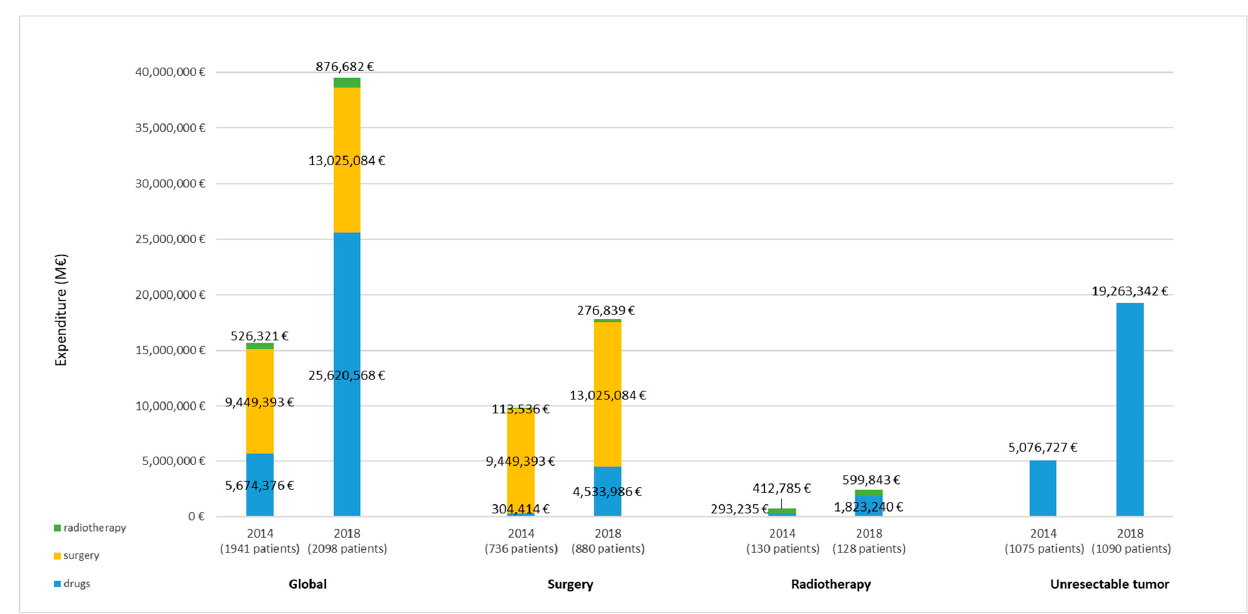
Figure 3. Pharmaceutical expenditure in 2014 and 2018 according to treatment pattern. Notes: The aggregated costs of the procedures were determined according to the treatment pattern followed in each patient. The costs for the year when each procedure was performed were imputed. Global: patients who receive any of the treatments described below. Surgery: patients receiving surgery with a curative intent with or without neoadjuvant and/or adjuvant pharmacological treatment, and/or complementary radiotherapy; also includes different lines of treatment for tumor recurrence. Radiotherapy: patients with radiotherapy with a curative intent, with or without pharmacological treatments; also includes different lines of treatment for tumor recurrence. Unresectable tumor: patients who only receive pharmacological treatments with a palliative